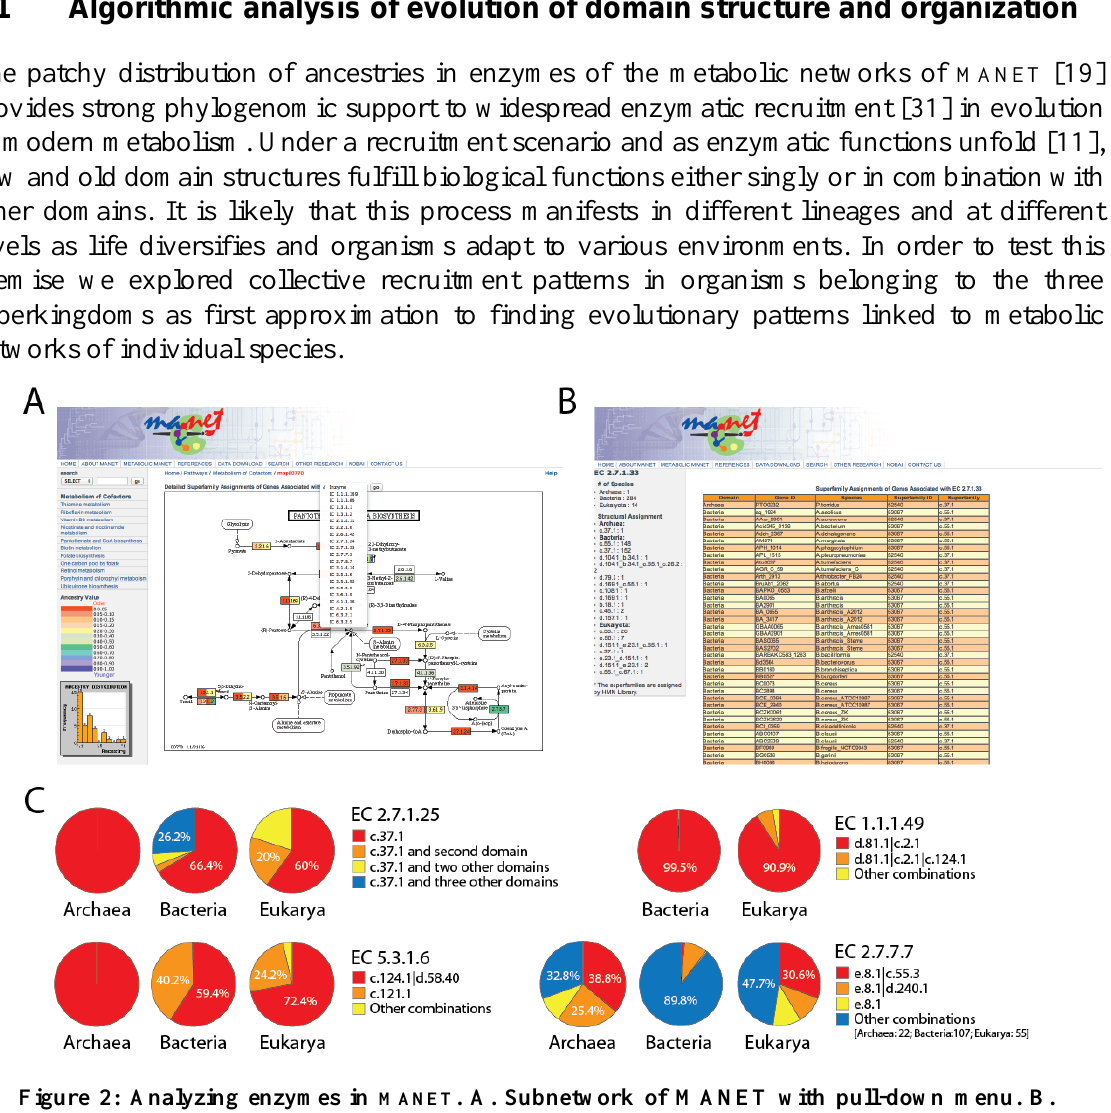
Figure 2: Analyzing enzymes in MANET . A. Subnetwork of MANET with pull-down menu. B. Structural annotations in species and related statistics obtained by clicking enzyme EC 2.7.1.33 in the subnetwork pull-down menu (only the top segment of the scroll-down list is shown). C. Examples of the enzymatic distribution of domain architectures in superkingdoms (see